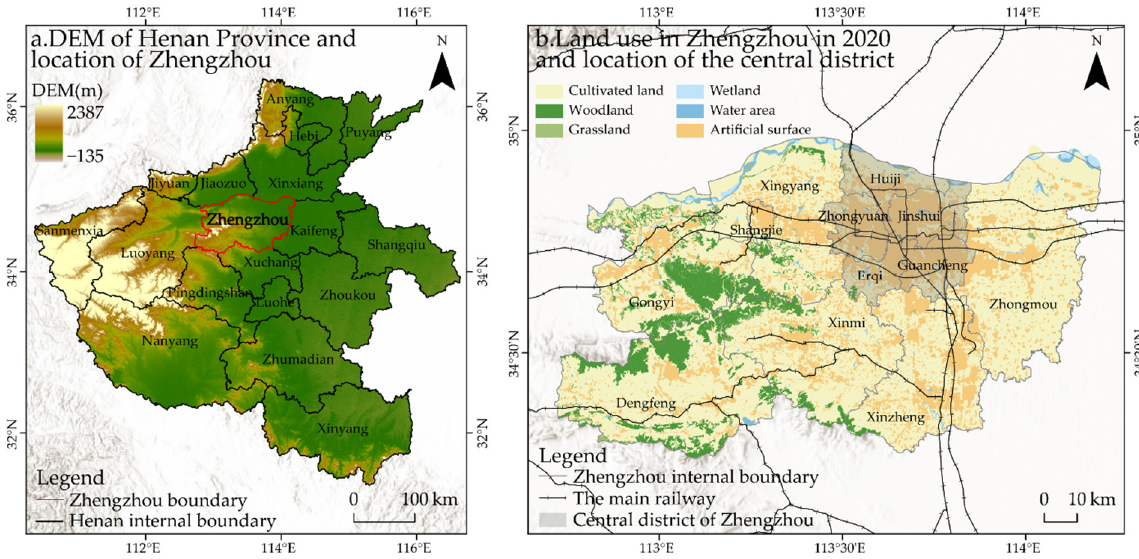
Figure 1. Geographical location of the central district of Zhengzhou.